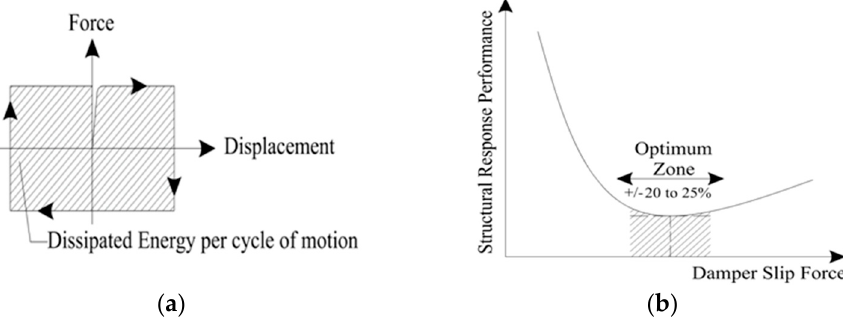
Figure 10. ( a ) Force-Displacement hysteresis loop of a friction damper, ( b ) optimal slip force effect on structural response.